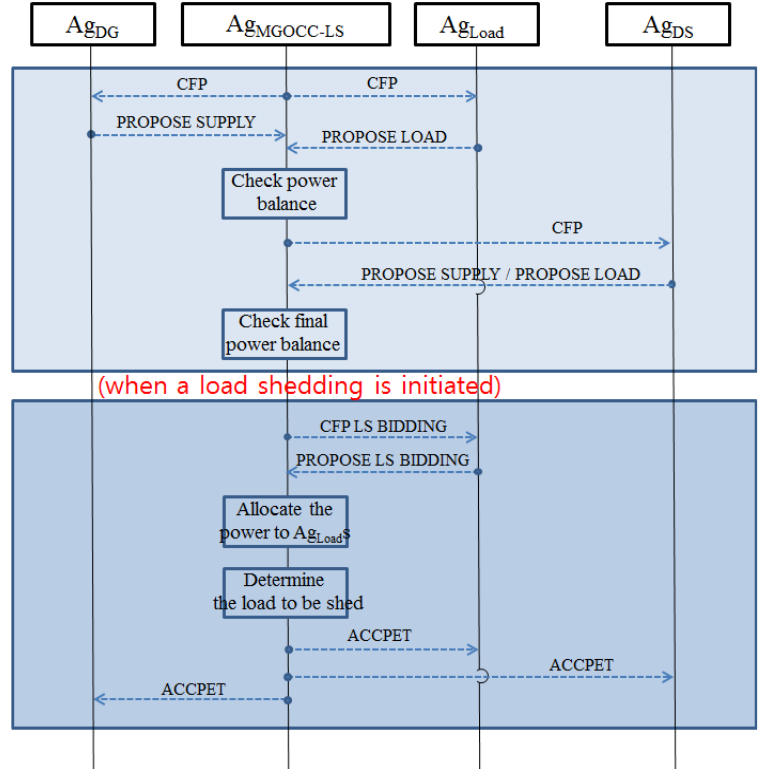
Figure 1. Message flow among agents for load shedding in a